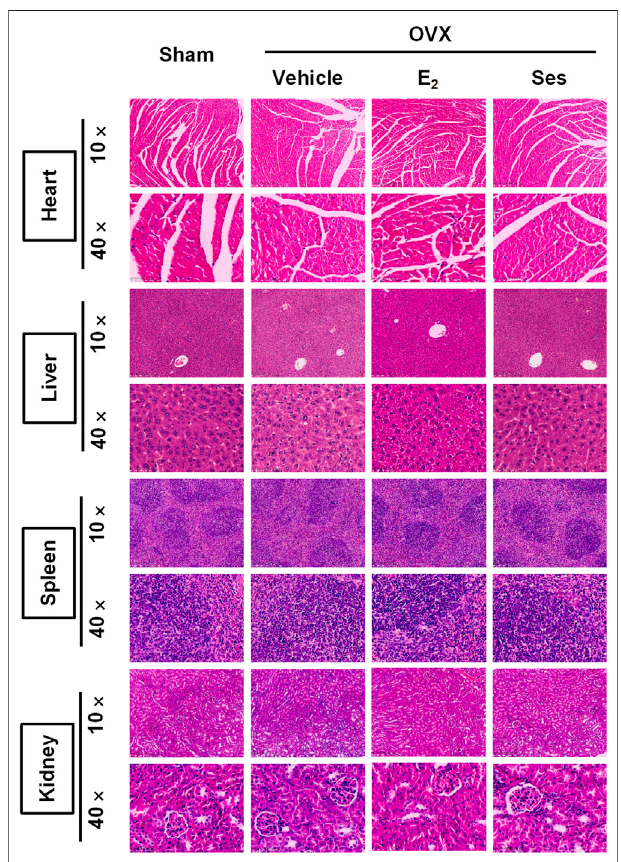
FIGURE 8 | Ses has no obvious toxic effect on the heart, liver, spleen or kidney in ovariectomized mice. Representative images of hematoxylin-eosin staining of the heart, liver, spleen and kidney. Ses, sesamolin; Vehicle, 1% DMSO in PBS; E 2 , estrogen; HE, hematoxylin and eosin.